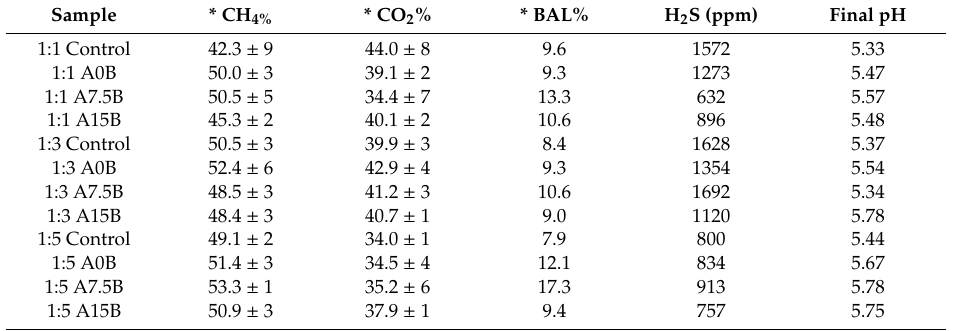
Figure 3. Biogas yields of spent grain and pot ale mixtures after alkaline and beating pre-treatments. Average of triplicate runs. Table 5. Components of generated biogas by anaerobic digestion of spent grain and pot ale